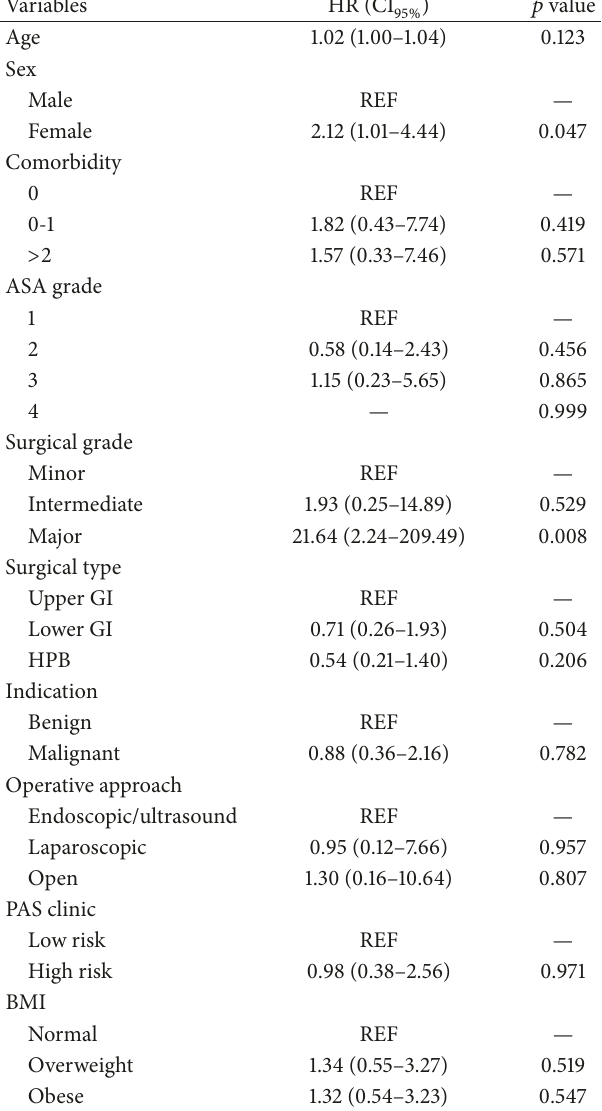
Table 4: Multivariate